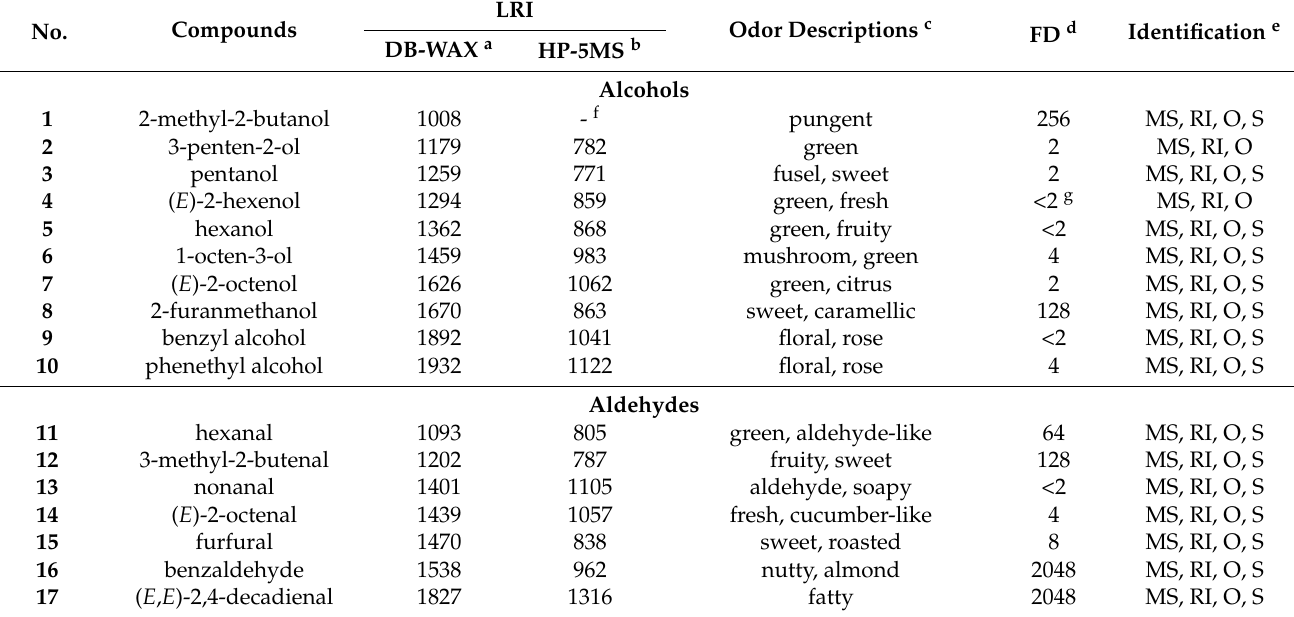
Table 1. Aroma-active compounds identified by GC-O and GC-MS from